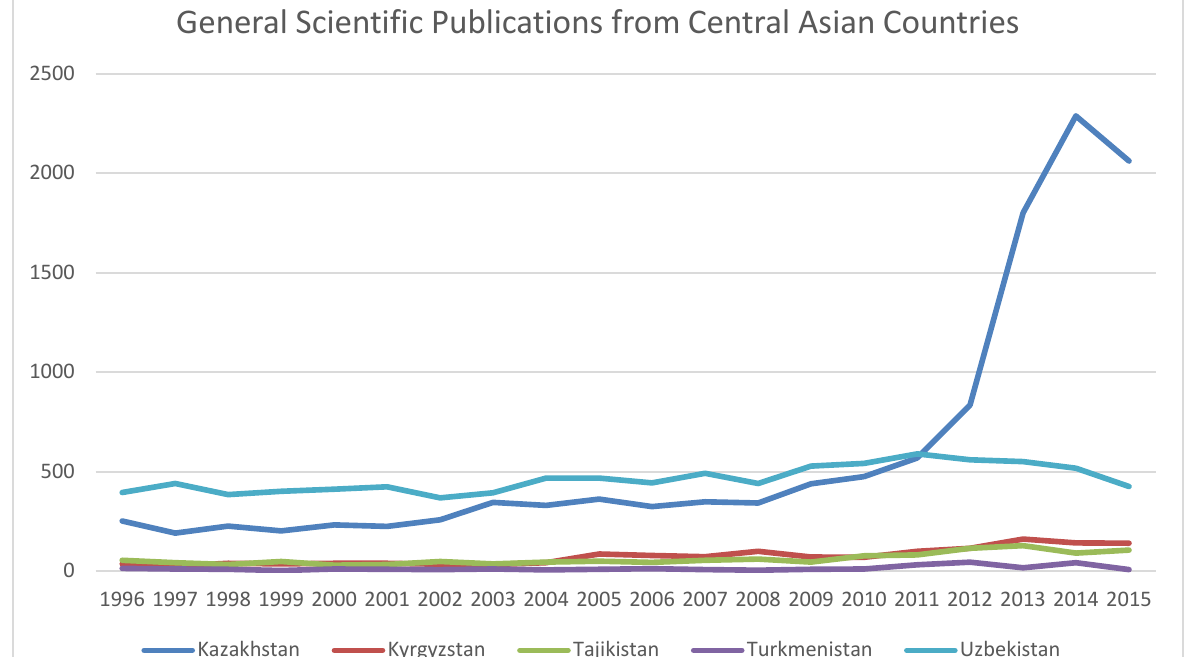
Figure 1: General scientific publication trends of Central Asian countries for 1996-2015 It is believed that the increase in publications from Kazakhstan starting in 2012 are likely from the addition of a policy that PhD candidates must submit at least one article to a journal with an impact factor greater than 0 9